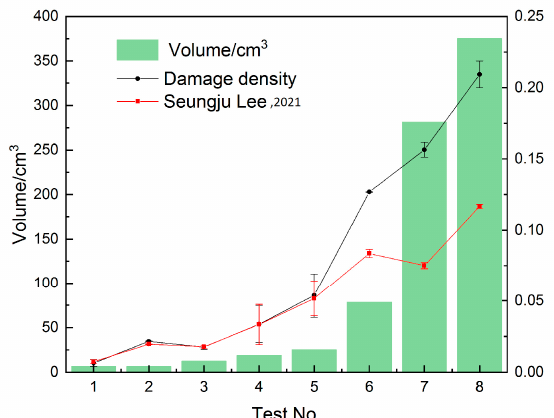
Figure 7. The plot of damage density and volume of defects